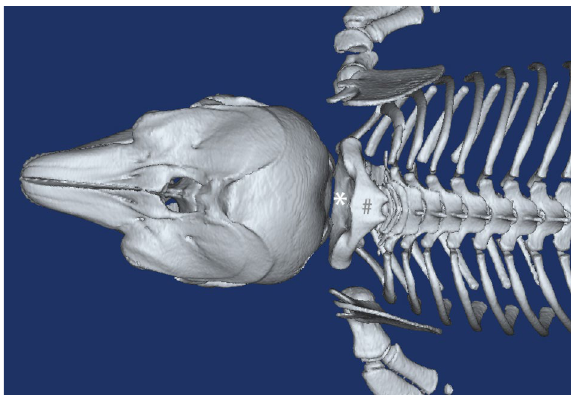
Figure 1. The 3D-reconstruction of bones in suboccipital region of the N.asiaeorientalis. Dorsal view of the suboccipital region. occi: occiput. *: the atlanto-occipital interspace. #: the fused spinous processes of the first three